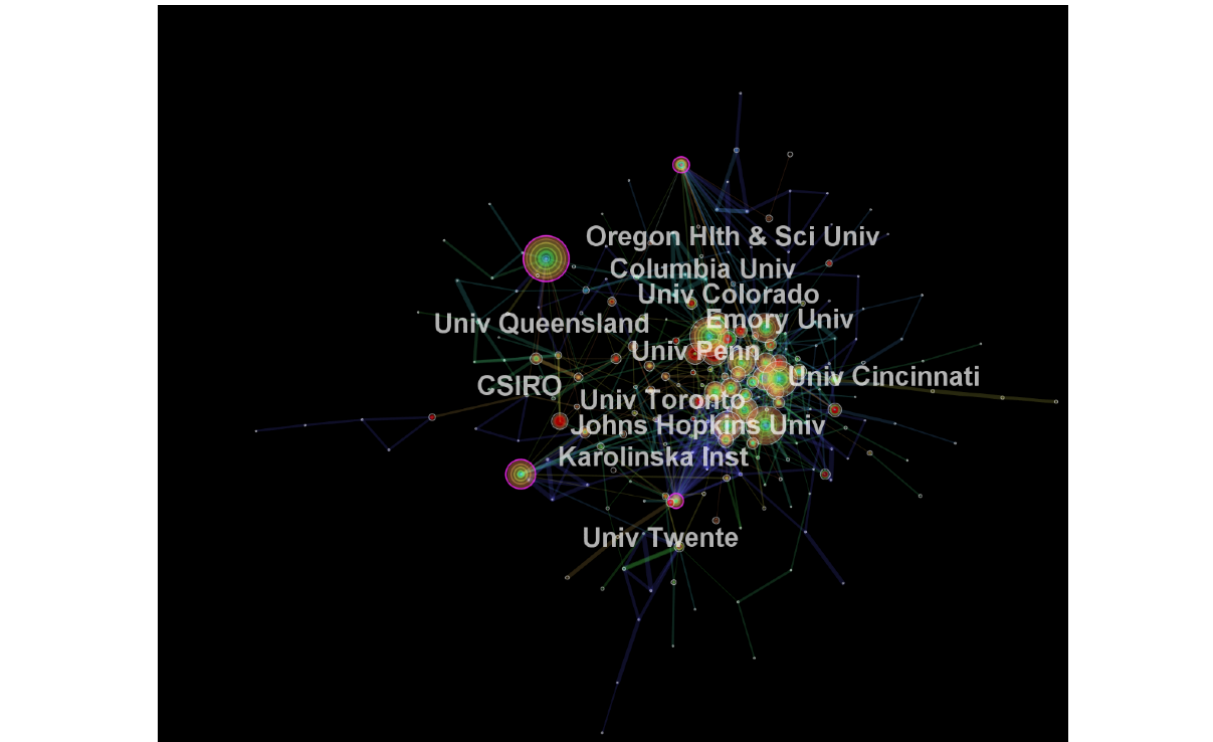
Figure 3. Institutional collaborations in telemedicine research. CSIRO: Commonwealth Scientific and Industrial Research Organisation; Hlth: Health; Inst: Institute; Sci: Science; Univ: